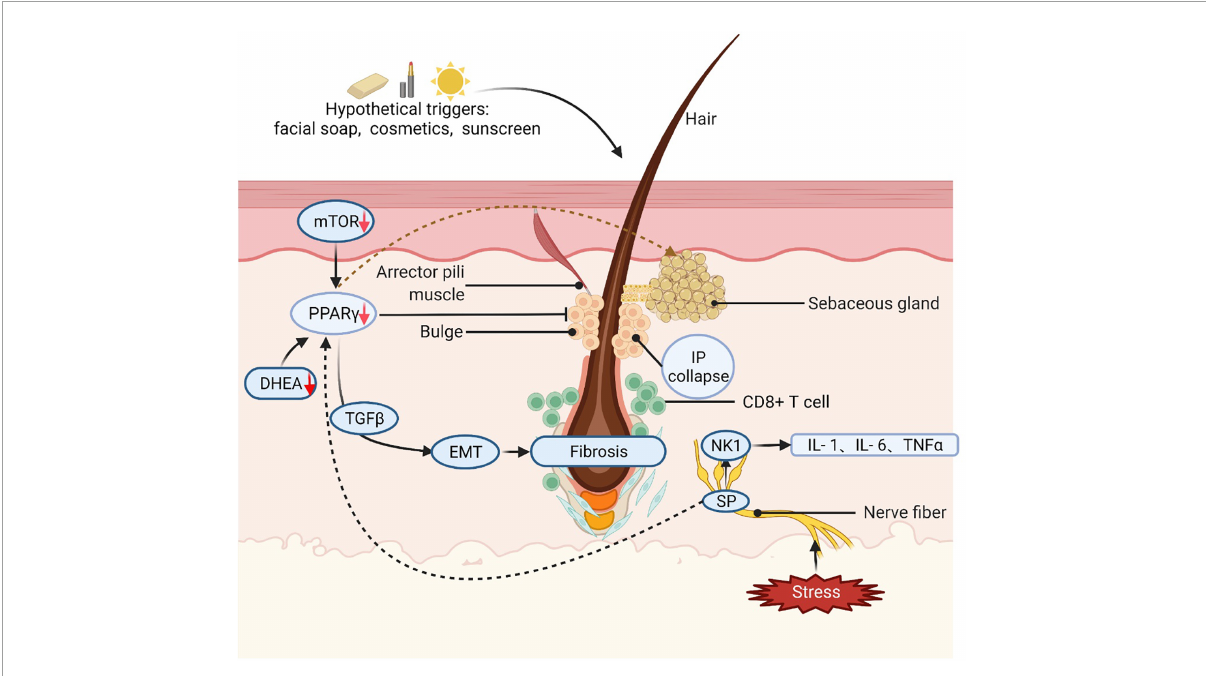
GRAPHICALABSTRACT Different hypothetical triggers, such as facial soap, cosmetics, sunscreen, or stressful conditions, can cause FFA in potentially genetically susceptible individuals. PPAR- γ /TGF- β pathway plays an essential role in EMT and fibrosis. mTOR signaling works as a modulator of PPAR- γ activity and lipid homeostasis. Arrows and lines indicate a regular relationship between two elements mTOR: mammalian target of rapamycin; PPAR- γ : peroxisome proliferator-activated receptor γ ; DHEA: dehydroepiandrosterone; HF: hair follicle; IFN: interferon; TGF- β : transforming growth factor- β ; IP: immune privilege; EMT: epithelial-mesenchymal transition; SP: substance P; NK-1: Neurokinin-1. Created with BioRender.com (accessed on 7 February